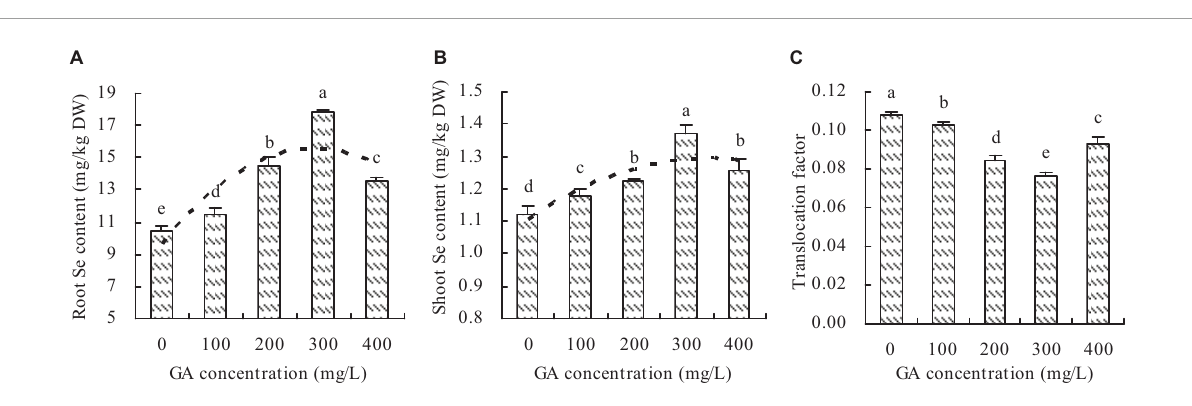
FIGURE4 Se content in C . betacea . (A) Root Se content. (B) Shoot Se content. (C) Translocation factor (TF, shoot Se content/root Se content). Different lowercase letters indicate significant differences among the treatments (Duncan’s Multiple Range Test, P <